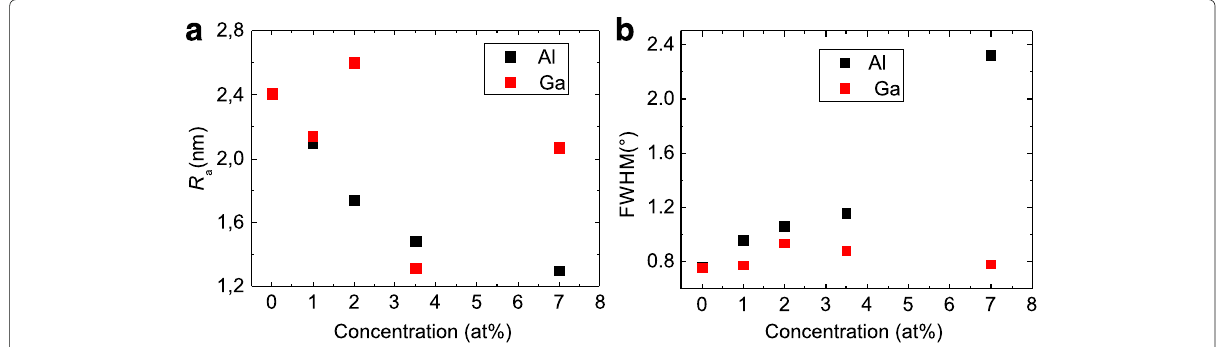
Fig. 1 Surface roughness ( a ) and the FWHM of rocking curves ( b ) of the seed layers as a function of the Al or rather Ga